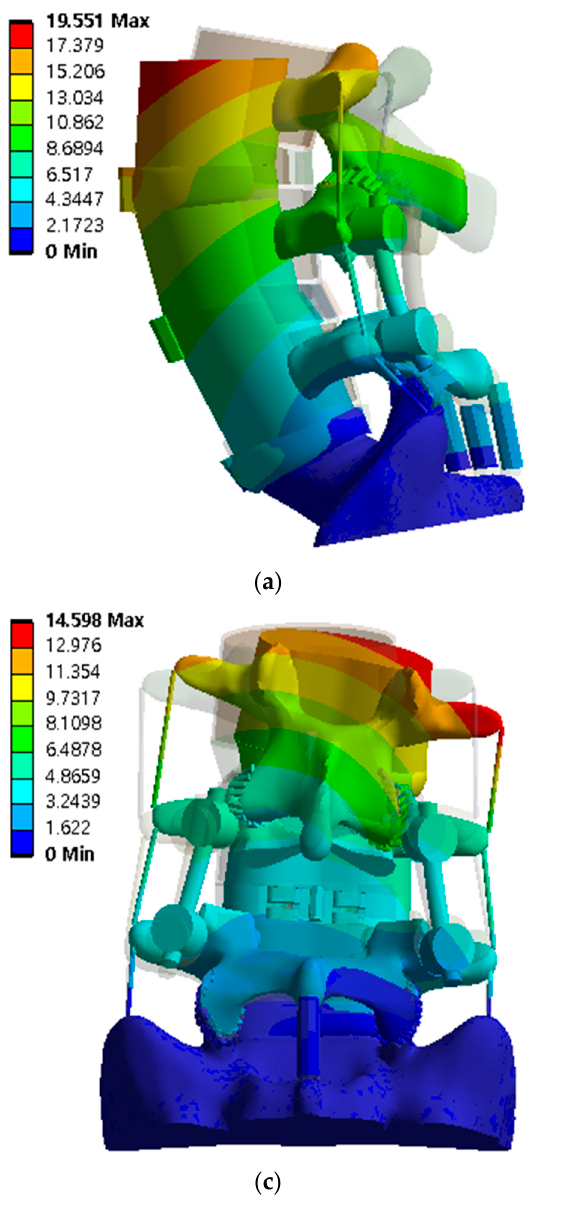
Figure 7. The deformation distribution of the lumbar spine at spinal implant porosity of 81% in each spinal motion: ( a ) flexion; ( b ) extension; ( c ) lateral bending; and ( d ) rotation (unit: mm).